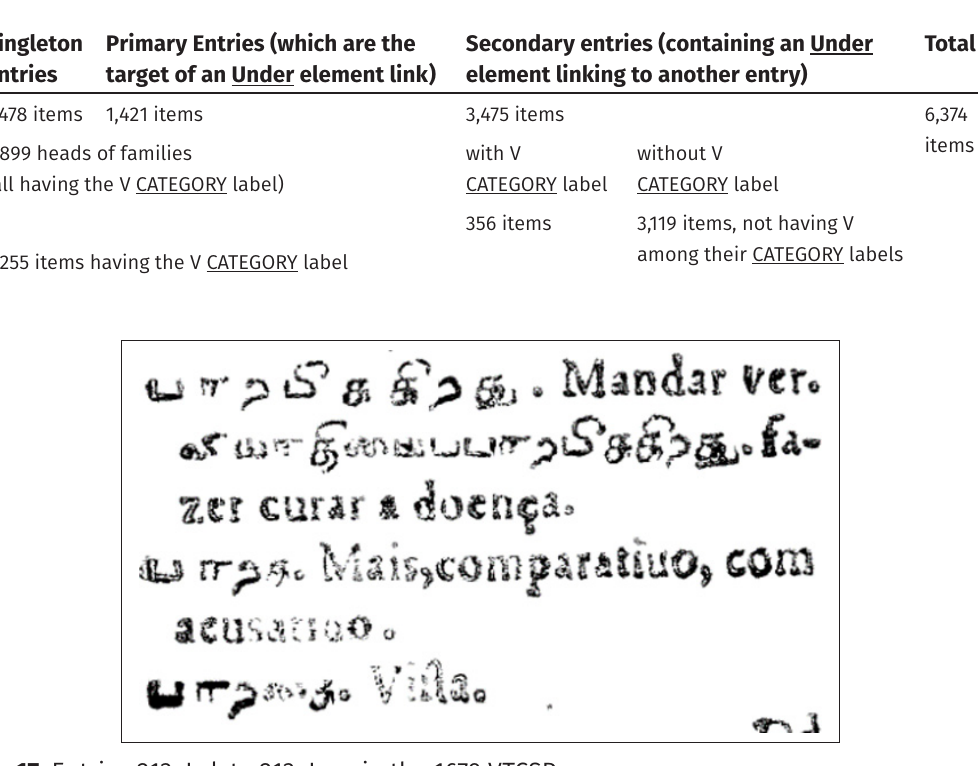
Table 4: Preliminary repartition of the 6,374 entries belonging to the verbal paradigm in the VTCSP into 2,899 families.